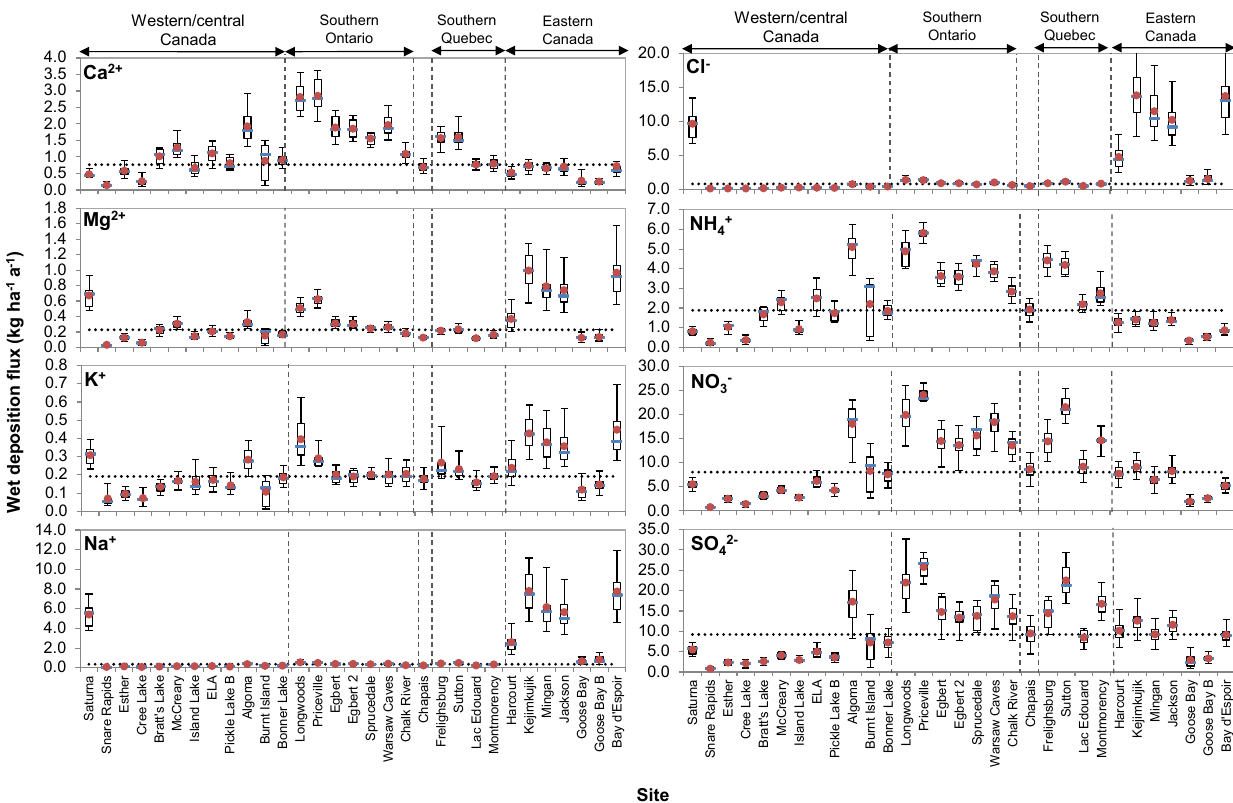
Figure 6. Geographical patterns of the annual wet deposition of ions. Sites are arranged in order from western to eastern Canada. The blue line indicates the median; the red dot indicates the mean; the box and whiskers include the interquartile range and the 5th to 95th percentile range, respectively; and the dotted line is the overall median among the